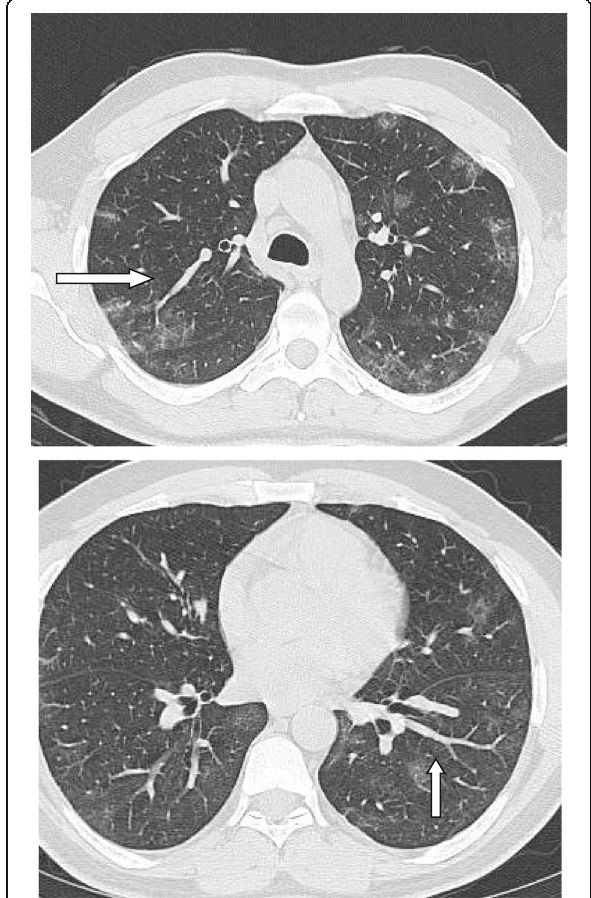
Fig. 20 Dilated pulmonary vessels in patient with acute COVID-19 pneumonia